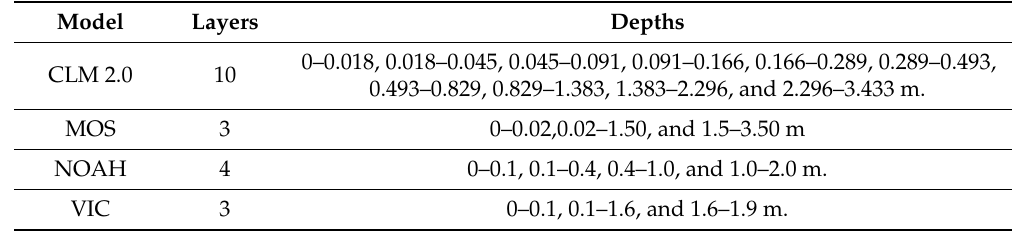
Table 1. Vertical layering structure of the four Land Surface Models